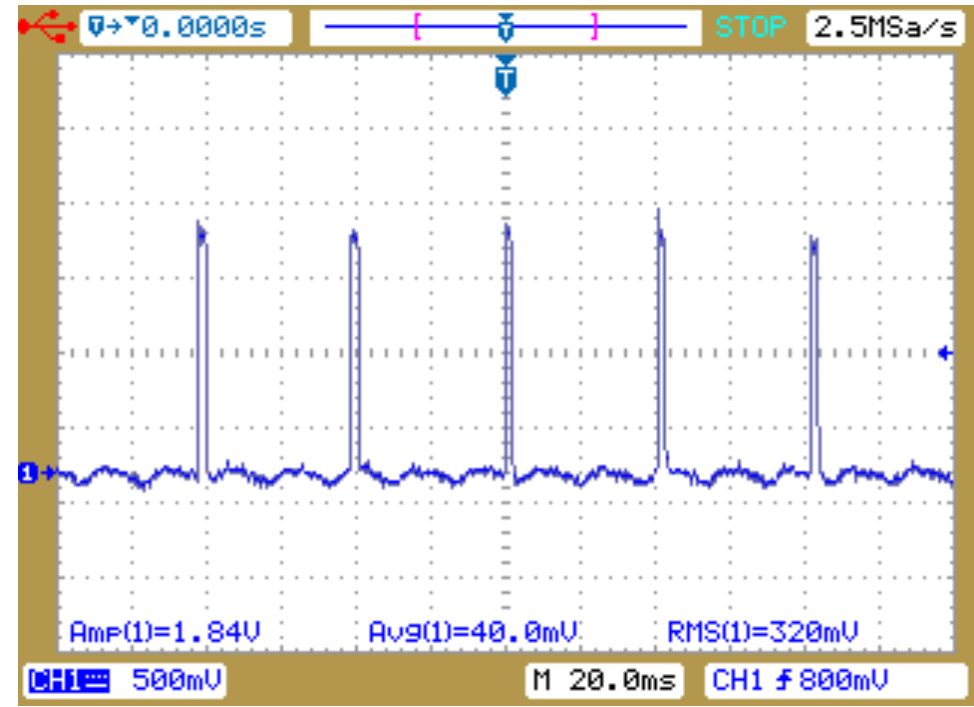
Figure 1. WiFi signal without traffic with BI 40 ms.